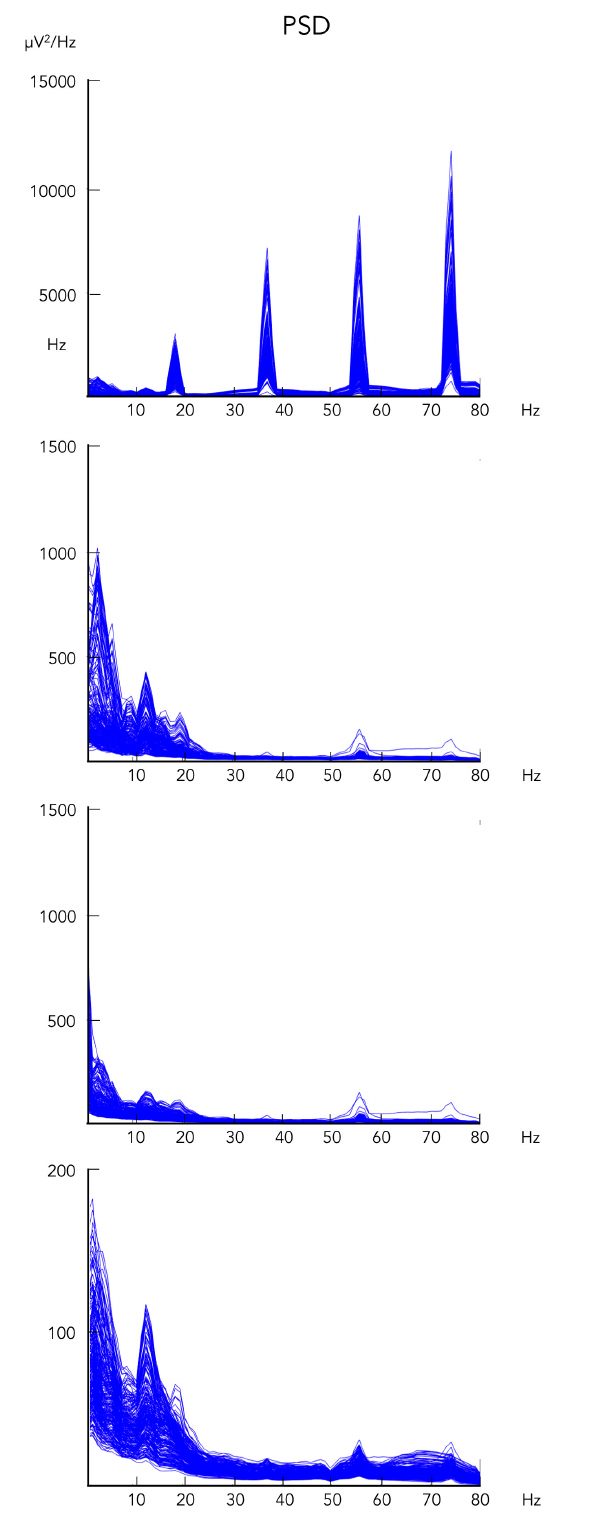
Frontiers in Neuroscience |